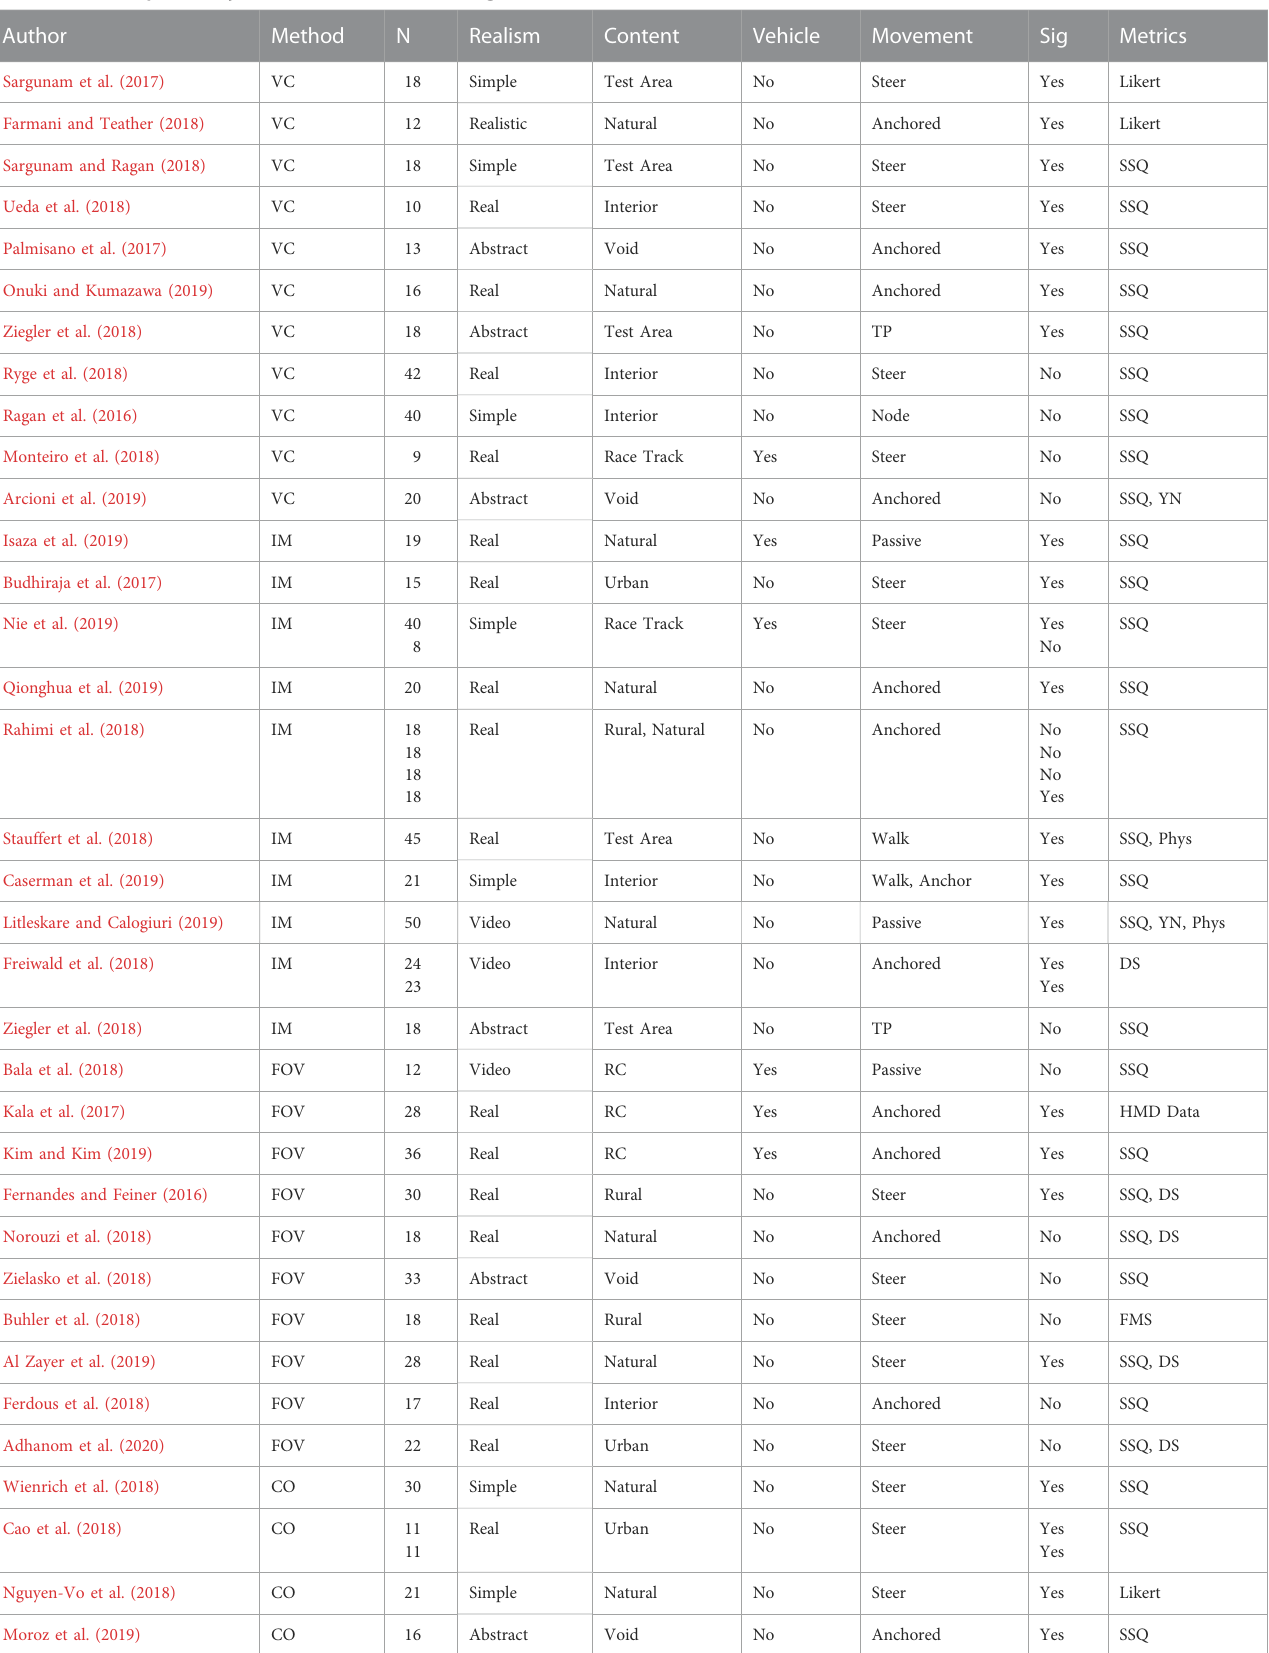
TABLE1Tableofcollecteddatafromthe fi rst fi vecategoriesofacceptedpapers.TheseCategoriesareVirtualCameraManipulation(VC),ImageManipulation(IM),Field of View (FOV), Companion Object (CO), and Virtual Scene Design